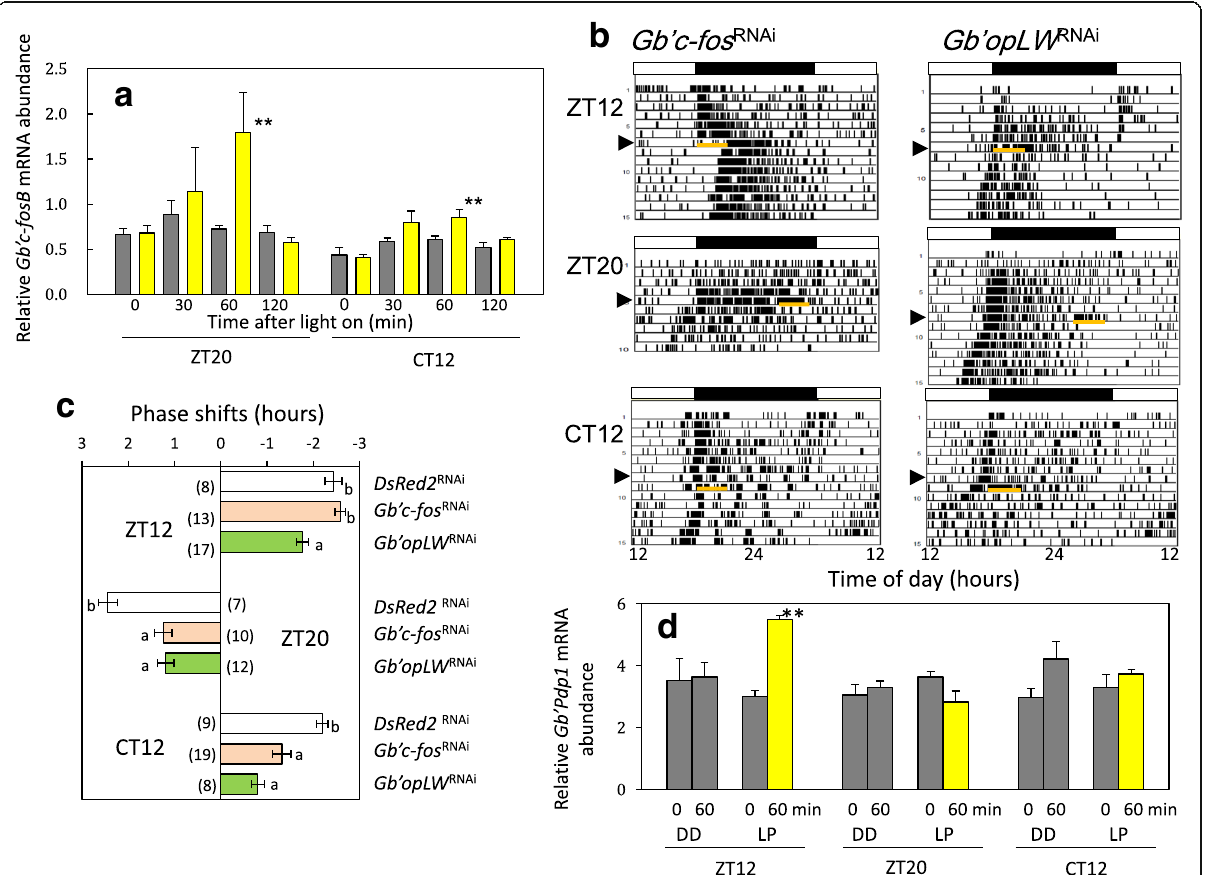
Fig. 3 Changes of Gb ’ c-fosB mRNA levels caused by light exposure ( a ), effects of RNAi of Gb ’ c-fos and Gb ’ opLW genes on the light-induced phase shifts of locomotor rhythms ( b , c ), and effects of Gb ’ c-fos RNAi on the light induced Gb ’ Pdp1 expression ( d ) in the cricket Gryllus bimaculatus . a Gb ’ c-fosB was upregulated by light exposure at ZT20 and CT12, and a statistically significant difference was evident after 60 min of exposure (** P < 0.01, t-test). The effect was greater in the late night (ZT20). Yellow and grey bars indicate the results with and without light exposure, respectively. b Phase shifts of locomotor rhythm caused by a 3 h light phase extension at ZT12 or 3 h light exposure at ZT20 or CT12 (orange bars). Black and white bars indicate dark and light phases, respectively. Arrow heads indicate the day of transfer to constant darkness. c Average phase shifts caused by a light phase extension at ZT12 or by a 3 h light pulse given at ZT20 or CT12. Error bars indicate SEM. Different lower-case letters indicate that values are significantly different (ANOVA followed by Tukey-Kramer test, P <0.05). Gb ’ c-fos RNAi suppressed the light-induced phase shifts at ZT20 and CT12 but not at ZT12, and Gb ’ opLW RNAi strongly suppressed them in all cases (ANOVA followed by Tukey-Kramer test, P<0.01). d Effects of light exposure on Gb ’ Pdp1 mRNA levels at ZT12, ZT20, and CT12 in Gb ’ c-fos RNAi crickets. Yellow and grey bars indicate the results with and without 60 min light exposure, respectively. Light phase extension at ZT12 induced significant upregulation of Gb ’ Pdp1 expression (** P < 0.01, t-test) in Gb ’ c-fos RNAi crickets, while no apparent effect was observed following light exposure at ZT20 and